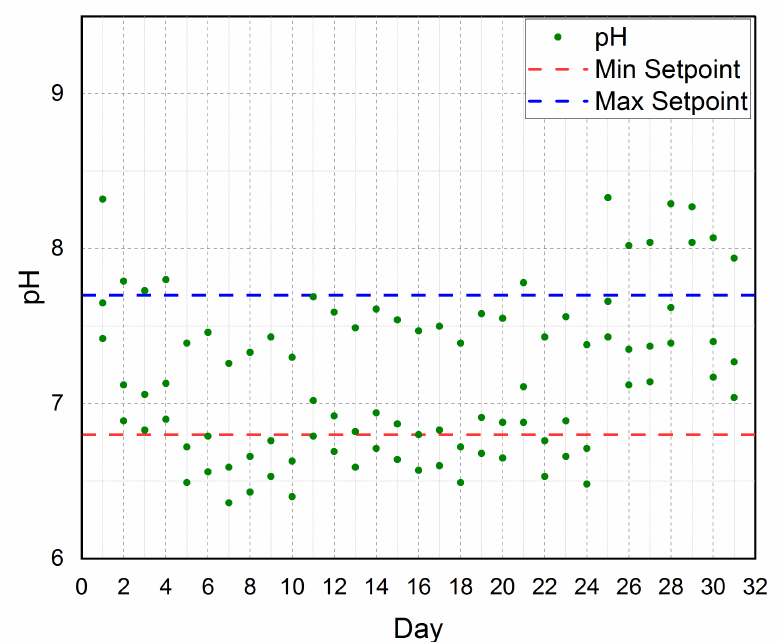
Figure 14. The three months average for water pH according to the minimum setpoint and maximum setpoint considered in our